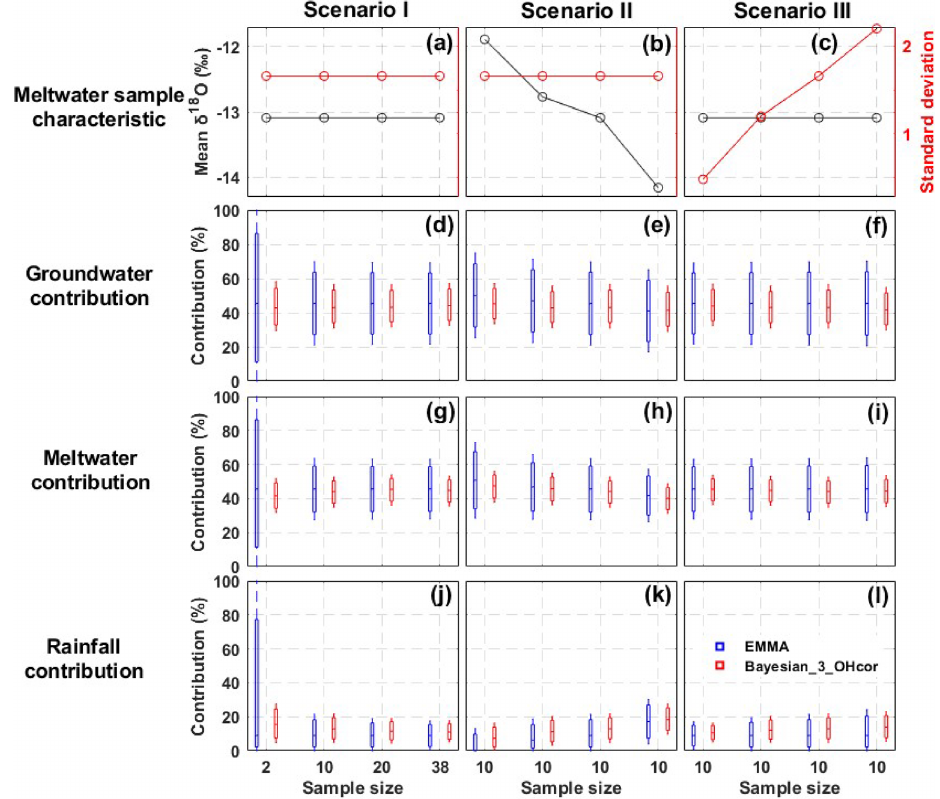
Figure 8. Sensitivity of the CRCs estimates to the sample size (Scenario I), the mean (Scenario II), and standard deviation (Scenario III) of δ 18 O of meltwater samples in the glacier melt season. Red boxes show the contributions estimated by the Bayesian_3_OHcor, and the blue boxes refer to the contributions estimated by the